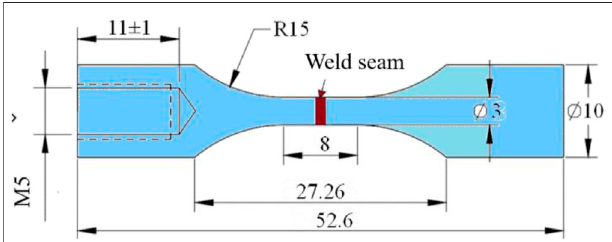
FIGURE 2 | Schematic diagram of the fatigue specimen (unit: mm).